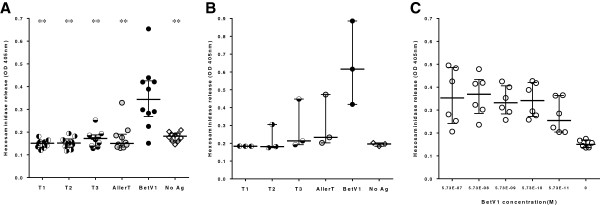
Degranulation of rat basophil lines induced by AllerT and its respective individual COPs T1, T2 and T3. Beta-hexosaminidase release was measured from RBL-2H3 cells loaded with sera obtained from r Bet v 1-sensitized mice and stimulated in panel A. with 5.7 nM rBet v 1, T1, T2, T3, AllerT or left unstimulated, n=10; in panel B: with 57 nM rBet v 1, T1, T2, T3, AllerT or left unstimulated, n=3; panel C: Beta-hexosaminidase release from RBL-2H3 cells loaded with 2 sera (dilutions 1:10, 1:50 and 1:100) obtained from r Bet v 1-sensitized mice and stimulated with serial concentrations of Bet v 1. Degranulation was measured using a colorimetric assay and is expressed in OD. Median and quartiles are indicated as horizontal bars. Data were analyzed by a non-parametric paired t test and compared to rBetv1. **p <0.01.